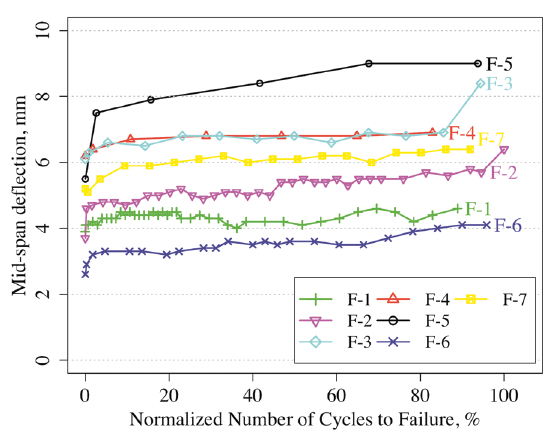
Figure 7. Midspan deflections versus normalized number of